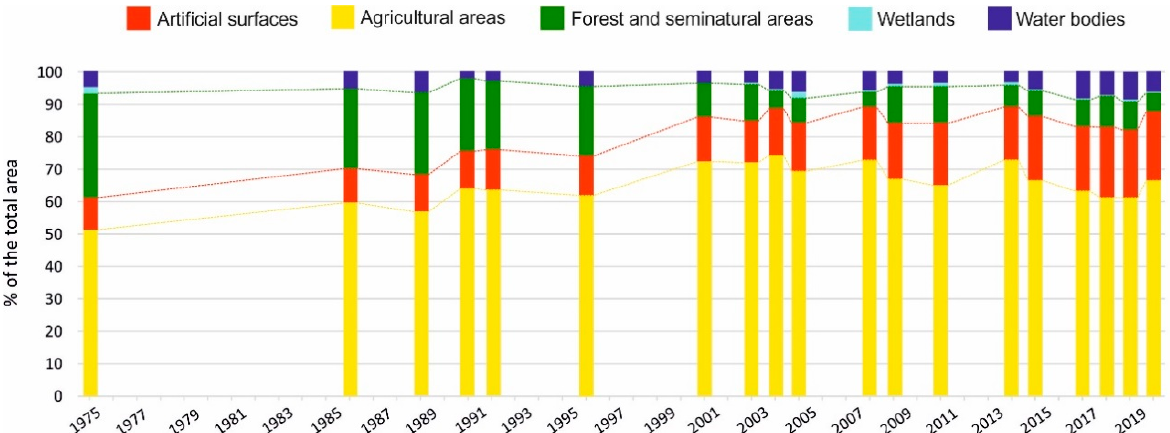
Figure 4. Percentage of the LULC size for each class within the Hanoi Province between 1975 and 2020.